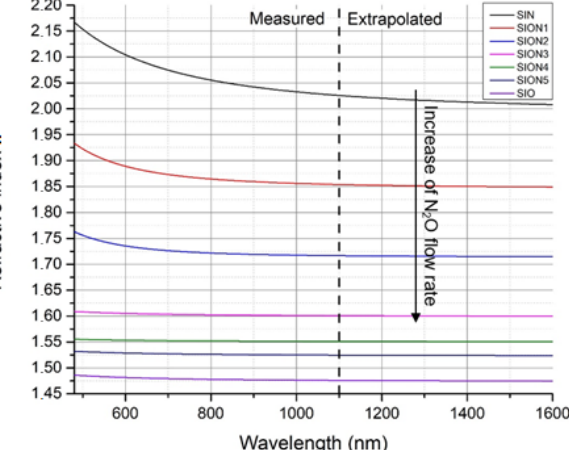
Figure 3. Refractive index as a function of wavelength for SiN, SiO x , and SiON films acquired using the Cauchy model on the measured ellipsometry